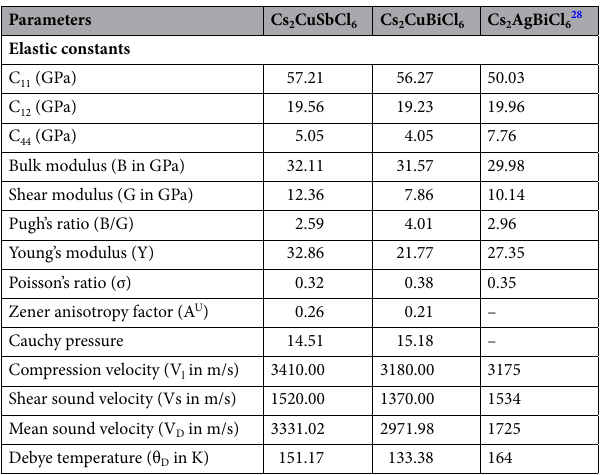
Table 2. Second-order elastic constants (SOECs) obtained by utilizing the energy-strain approach in the framework of GGA-PBE for Cs 2 CuMCl 6 (M = Sb, Bi).